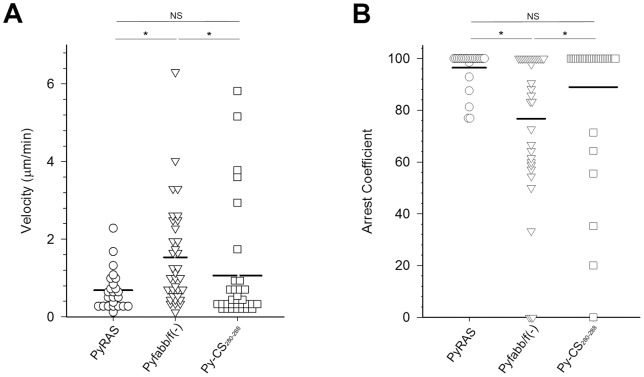
Tracking adoptively transferred Py-RAS and Pyfabb/f(−) activated CD8+ T cells in the livers of simultaneously infected mice.Mice were injected intravenously with 1–2 million PyXNL-GFP sporozoites and then immediately inoculated with 1 million labeled CD8+ T cells purified from the spleens of Py-RAS (circles), Pyfabb/f(−) (triangles), or Py-CS280–288 (squares) immunized mice 2 weeks after the second booster. Mean velocities (A) and arrest coefficients (B) of CD8+ T cells from mice immunized with Py-RAS versus Pyfabb/f(−) and Pyfabb/f(−) versus Py-CS280–288 differed significantly from each other (one-way ANOVA on Ranks). No significant difference was found for PyRAS versus Py-CS280–288. Adoptive transfer of CD8+ T cells into infected BALB/c mice was done immediately after PyXNL-GFP sporozoite inoculation. IVM was performed at 18 h post-infection. At least three mice were analyzed per experimental condition. *  =  p<0.05; NS  =  p>0.05.